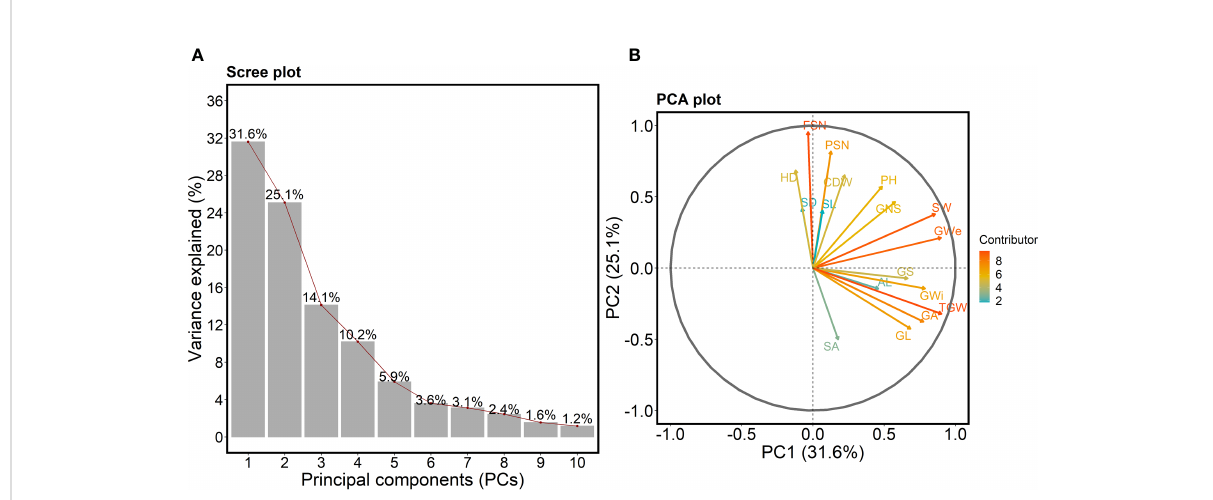
FIGURE 3 (A) Scree plot highlighting the fi rst ten principal components (PCs) describing the total variation present for all the studied traits. The x- and y- axis represent the fi rst 10 PCs and variance explained in percent, respectively. The red line shows the trend of the percentage of variance explained starting from PC1 to PC10. (B) PCA plot showing the PC1 on the x -axis and PC2 on the y- axis. The contribution of each trait towards PC1 and PC2 is indicated by the color-coded arrow with maximum contributors indicated by orange to red arrows and minimum contributors by cyan-colored arrows. The legend describes the strength of the contribution. PSN = potential spikelet number; FSN = fi nal spikelet number; SA = spikelet abortion (SA in %); SL = spike length (in cm); SW = spike weight (in g); SD = spike density; AL = awn length; GNS = grain number per spike; GL = grain length (in mm); GWi = grain width (in mm); GA = grain area (in mm 2 ); GWe = grain weight per spike (in g); GS = grain set (in %); TGW = thousand-grain weight (in g); HD = heading date (in days from January 1 st ); PH = plant height (in cm) and CDW = culm dry weight (in